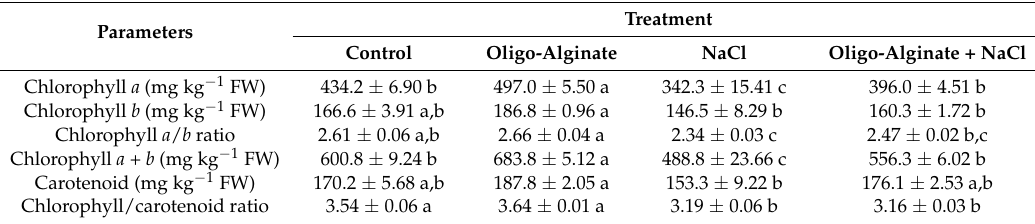
Table 2. Effect of oligo-alginate and NaCl on photosynthetic pigment concentrations in leaves of Eucomis autumnalis . Means ( ± standard errors) followed by the same small letter in the same row did not differ by Tukey test ( p ≤ 0.05).